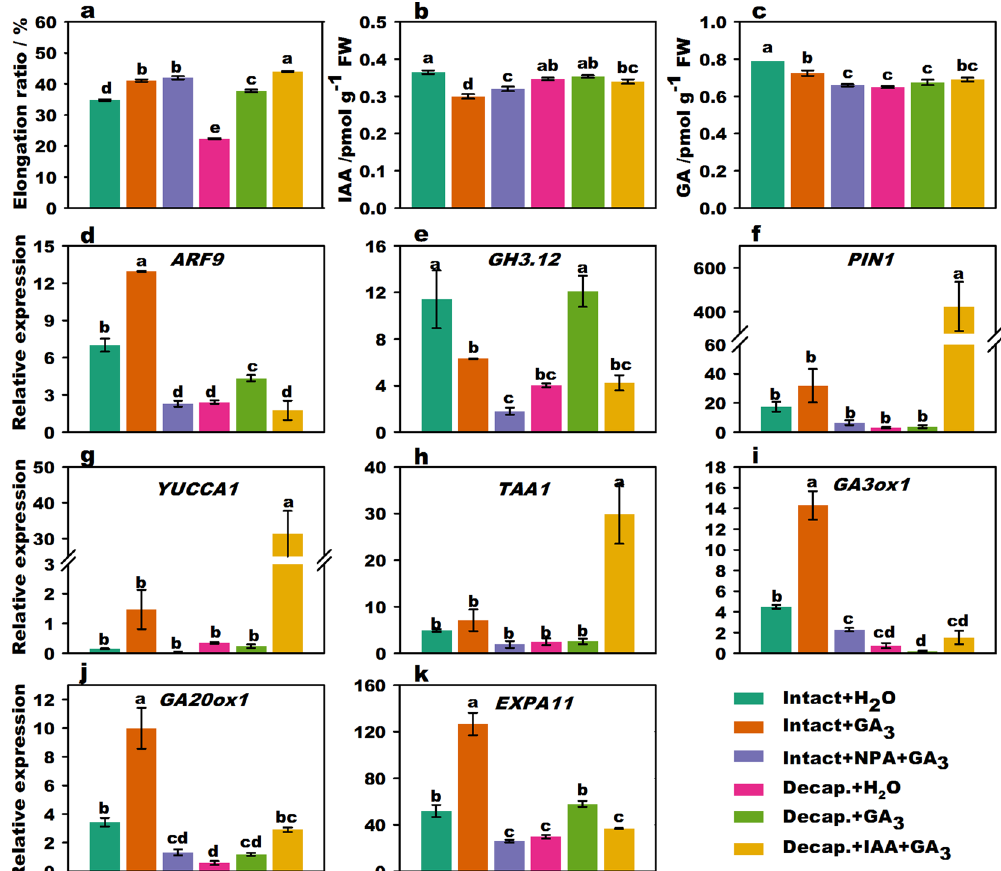
Figure 2. Effect of IAA and GA 3 treatment on stalk elongation, endogenous hormone content, and related gene expression of flowering Chinese cabbage. Stalk elongation ratio of flowering Chinese cabbage ( a ). Changes in endogenous IAA ( b ) and GA ( c ) contents in stalk tips treated with different phytohormones. The relative expression of signal transduction ( d , e ) genes, polar transport genes ( f ), IAA biosynthesis ( g , h ), GA biosynthesis ( i , j ), and cell expansion ( k )-related genes under different phytohormone treatments. Values with different letters indicate significant differences at p < 0.05, according to Duncan’s multiple range tests. Error bars indicate standard errors of three biological